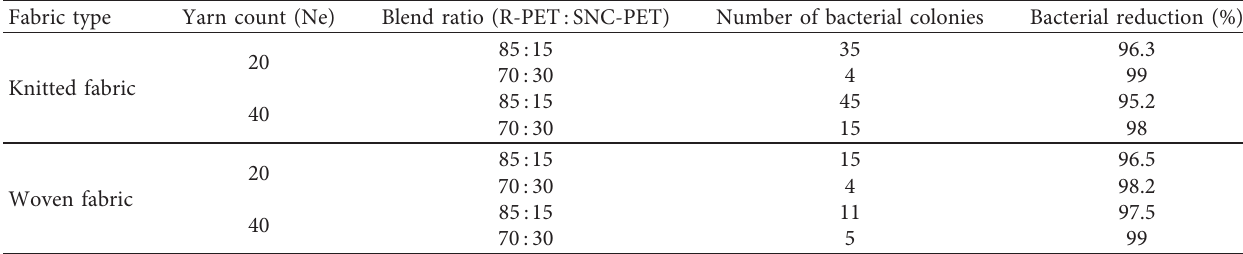
Table 11: Antibacterial activity results for E. coli